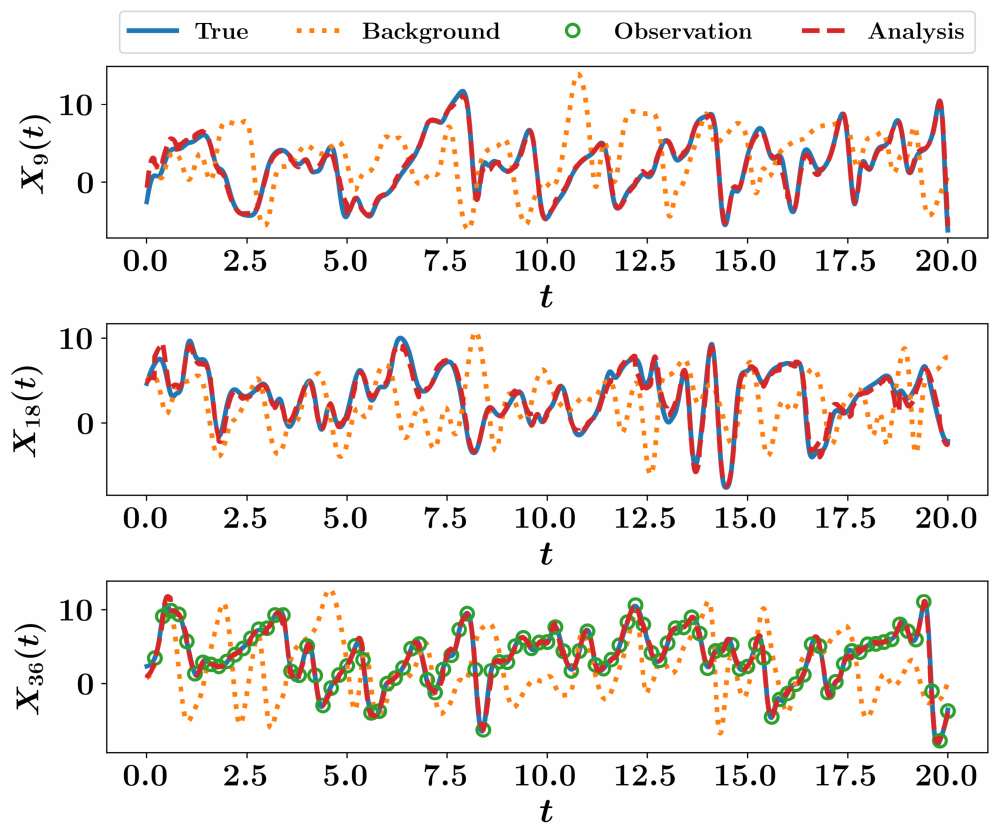
Figure 8. EnKF results for the Lorenz 96 system using an ensemble of 50